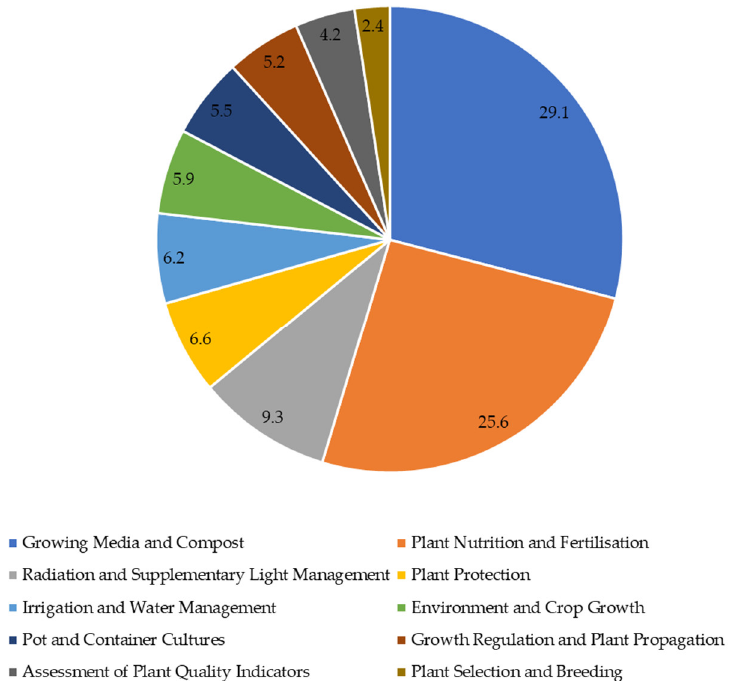
Figure 6. Main research topics in the agricultural sciences. Values are expressed as percentages ( n = 289).